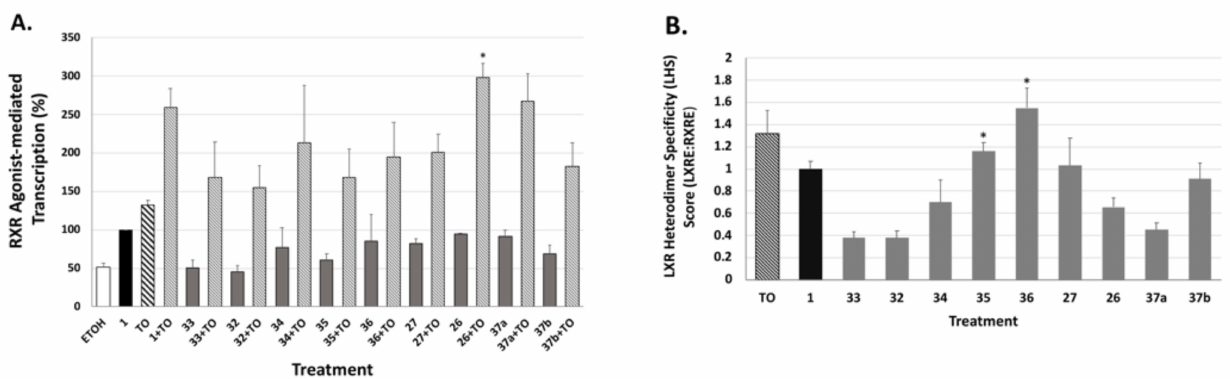
Figure 9. Evaluation of additional RXR agonists to potentiate LXRE-mediated transactivation in the absence and presence of LXR ligand T0901317. ( A ) Human HEK-293 cells were transfected and treated as described in Figure 8. LXRE-directed activity was compared to compound 1 (bexarotene), set to 100%. Values are means ± SD with indicated analog+TO exhibiting greater activity vs. compound 1+TO (* p , 0.05). ( B ) The “Heterodimer Specificity Score” (LHS) was determined by the LXRE:RXRE ratio with compound 1 set to 1.0. Values are means ± SD with indicated analogs exhibiting greater LHS vs. compound 1 (* p <